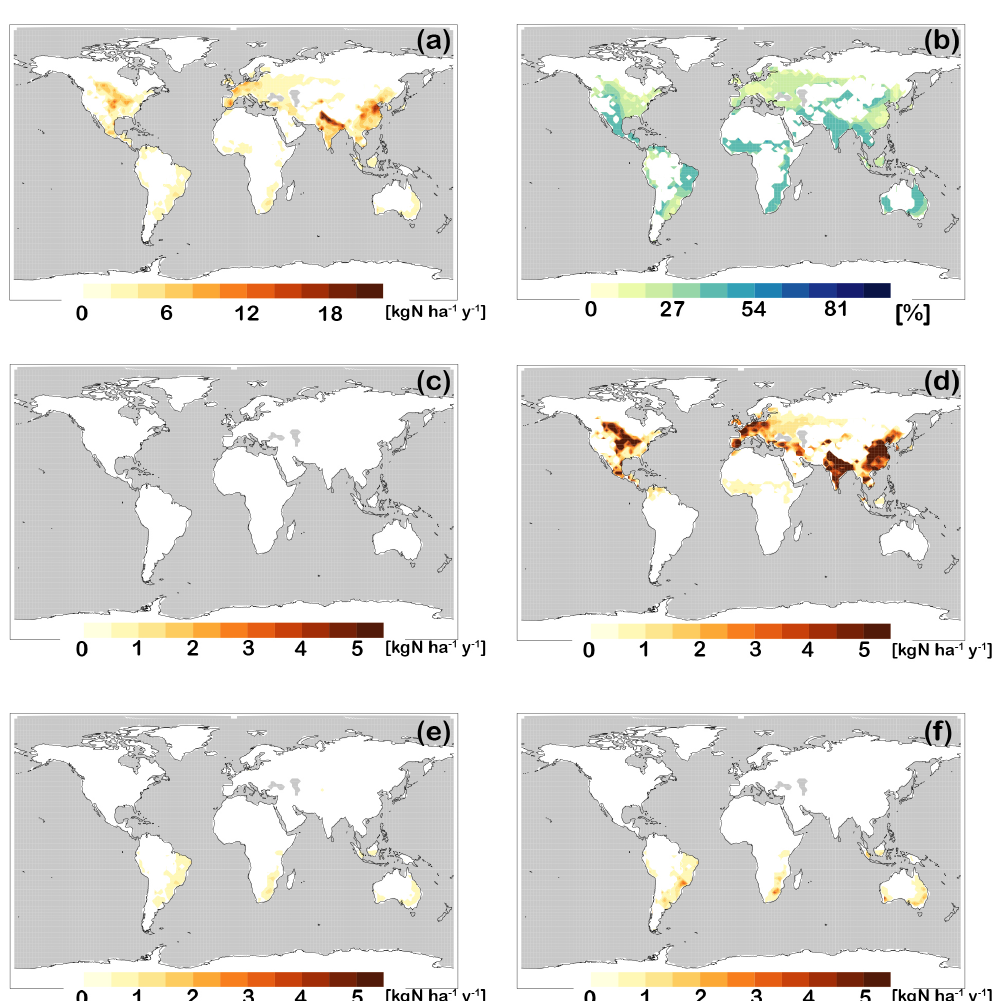
Figure 4. Simulated NH 3 emissions from synthetic fertilizer application from 1995 to 2004 for the present-day control simulation. Simulated emissions (kgNha − 1 yr − 1 ) as (a) an annual average, (c) January–February–March average, (d) April–May–June average, (e) July–August– September average, and (f) October–November–December average. Panel (b) shows simulated emissions as a percent of annual synthetic fertilizer